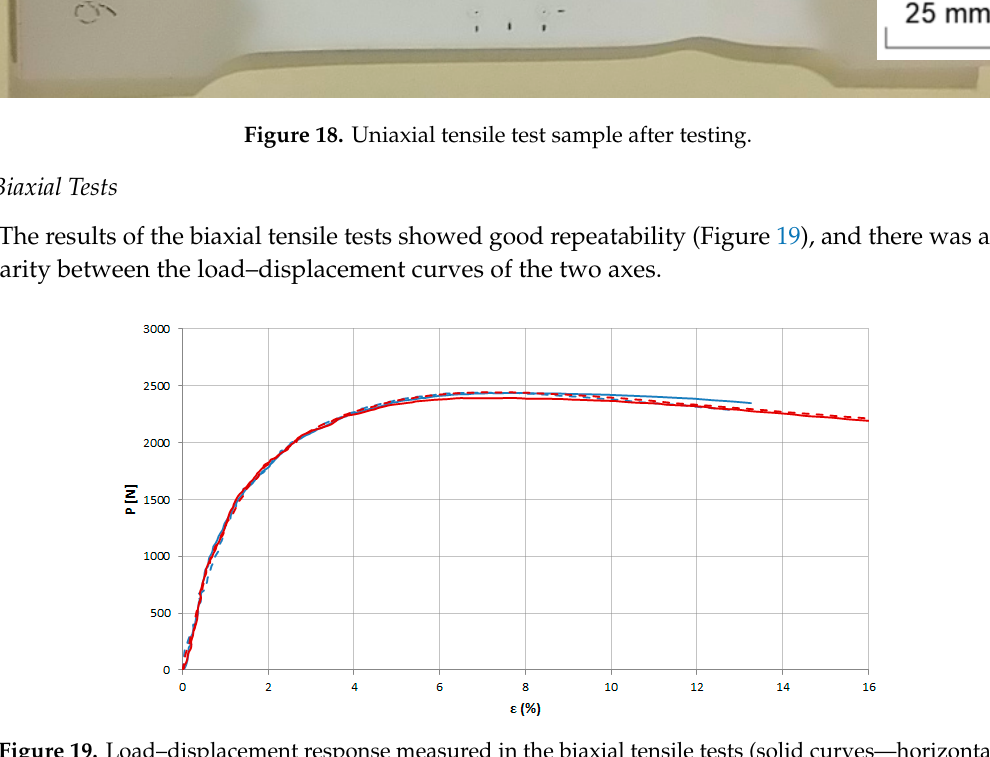
Figure 18. Uniaxial tensile test sample after testing.